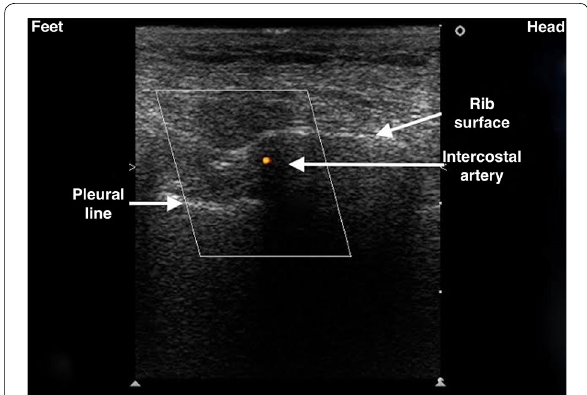
Fig. 2 Visualisation of intercostal vessels using Doppler ultrasound. The probe marker is facing the patient’s head (on the right of the screen). The colour Doppler box should be placed on the bottom edge of the rib and the depth reduced until the rib does not occupy the entire screen. Pulse repetition frequency (PRF) should be reduced until pulsation is detected